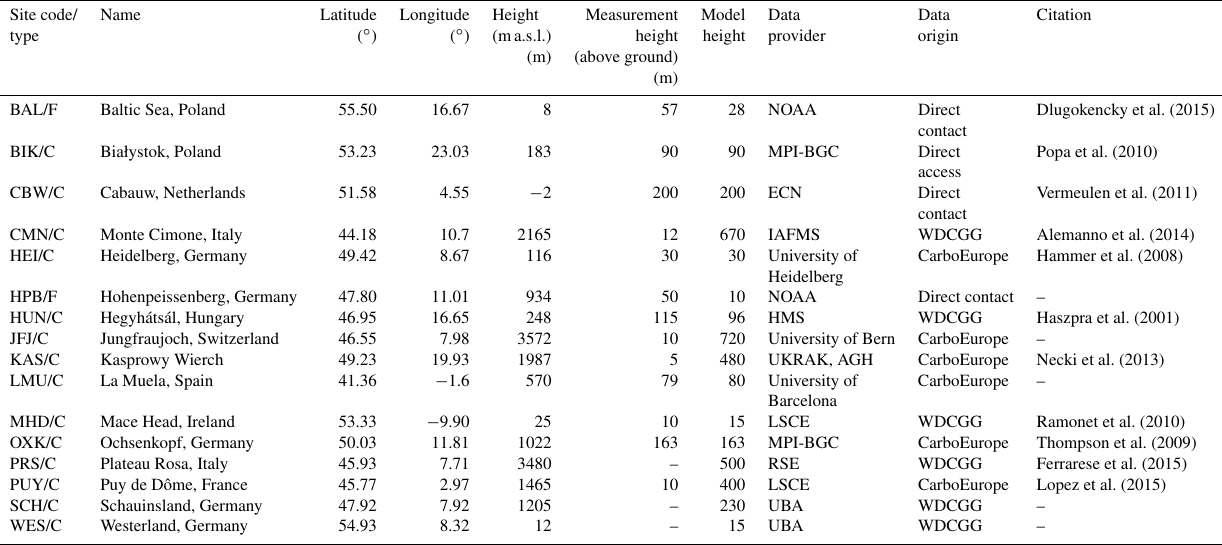
Table 1. Information on the stations used for the regional inversions. Same network applied for the synthetic data inversions and the real-data inversions in Kountouris et al. (2018). In the first column the term “type” stands for continuous (C) or flask (F) data. Under “Data origin” WDCGG means World Data Centre for Greenhouse Gases.